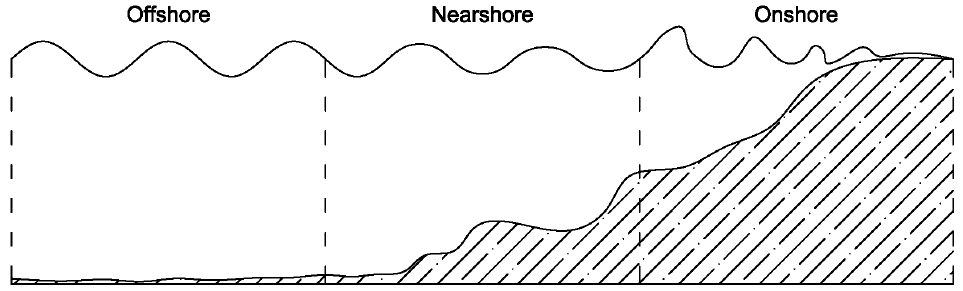
Figure 7. Classification of WEC based on the distance from the coastline. After this classification, a list of devices, divided into working principles, is